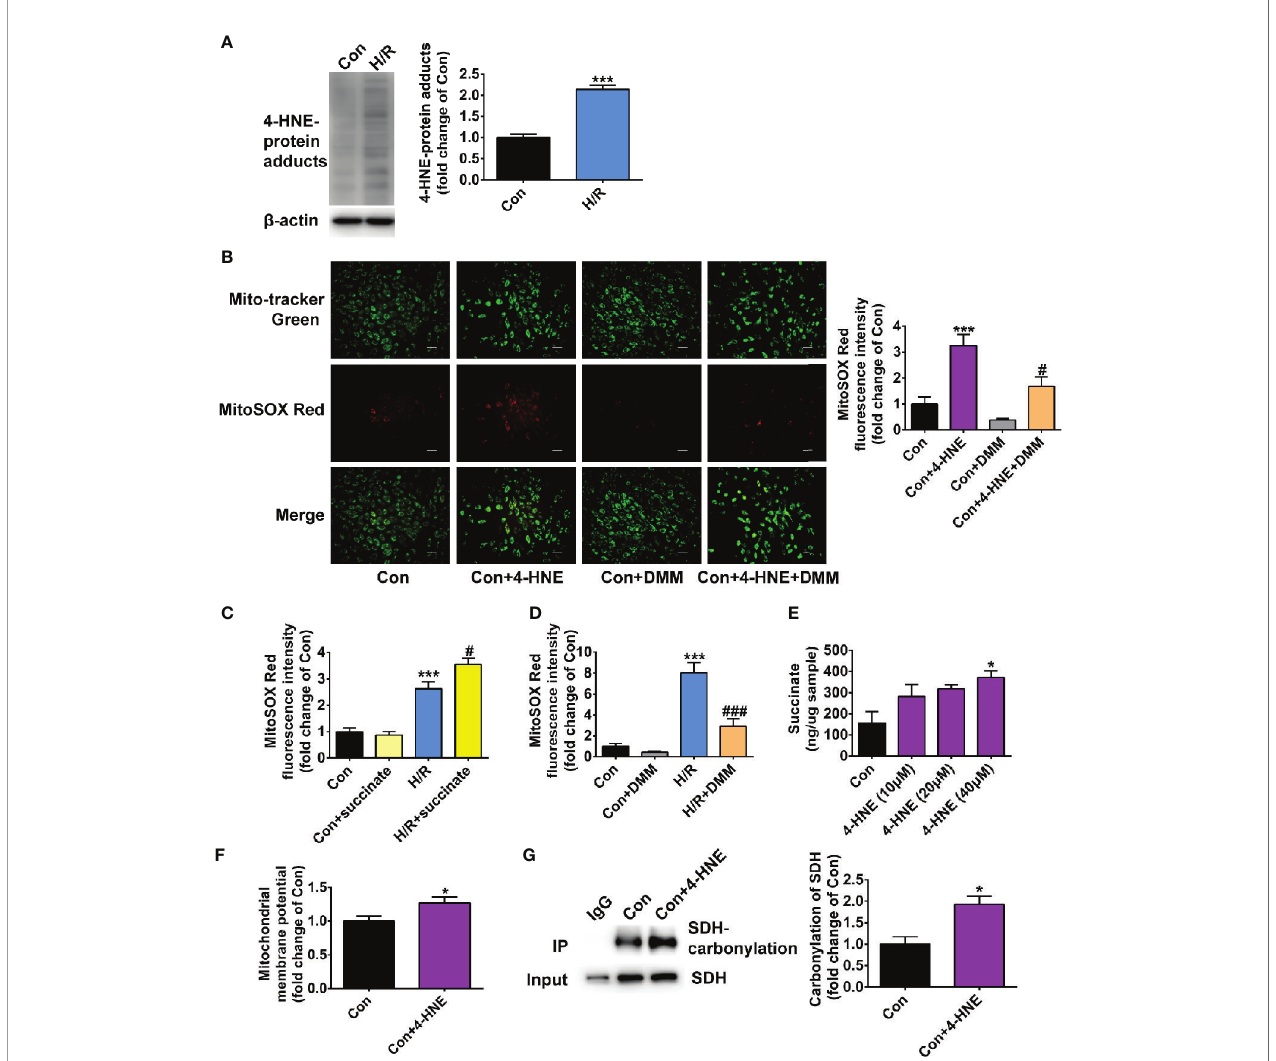
FIGURE 6 | The effect of 4-HNE on mitochondrial ROS levels, succinate accumulation, mitochondrial membrane potential and SDH carbonylation. (A) Representative immunoblots and quanti fi cation of 4-HNE-protein adducts under hypoxia/reoxygenation (H/R) ( n = 3 samples per group). (B) Representative photographs and quanti fi cation of mitochondrial ROS levels under the treatment of 4-HNE (40 m M) and 4-HNE (40 m M) +dimethyl malonate (DMM) ( n = 3 samples per group). (C, D) The mitochondrial ROS levels after the addition of succinate or dimethyl malonate (DMM) during hypoxia/reoxygenation (H/R) (n = 4 samples per group). (E) The levels of succinate under the treatment of 4-HNE ( n = 3 samples per group). (F) The quanti fi cation of mitochondrial membrane potential under the treatment of 4-HNE (40 m M) ( n = 3 samples per group). (G) Representative immunoblots and quanti fi cation of SDH carbonylation under the treatment of 4-HNE (40 m M) ( n = 3 samples per group). Group comparisons were performed by ANOVA with Tukey ’ s post hoc test or Student ’ s t-test. Data are presented as mean ± SEM. * P < 0.05, *** P < 0.001 versus Con group; # P < 0.05 versus Con +4-HNE group or H/R group; ### P < 0.001 versus H/R